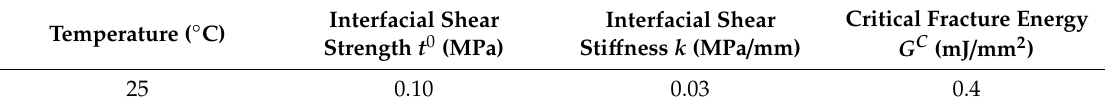
Table 1. Parameters of the cohesive zone model